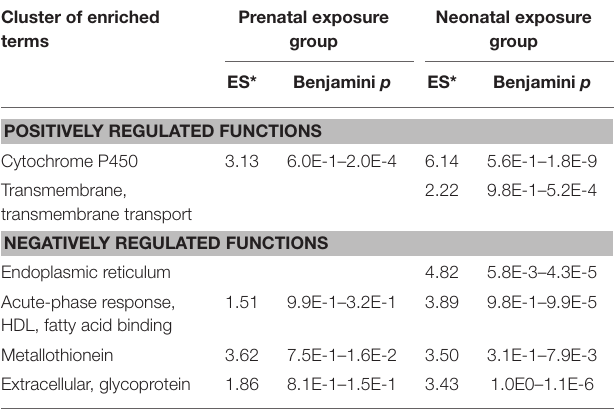
Cluster of enriched terms